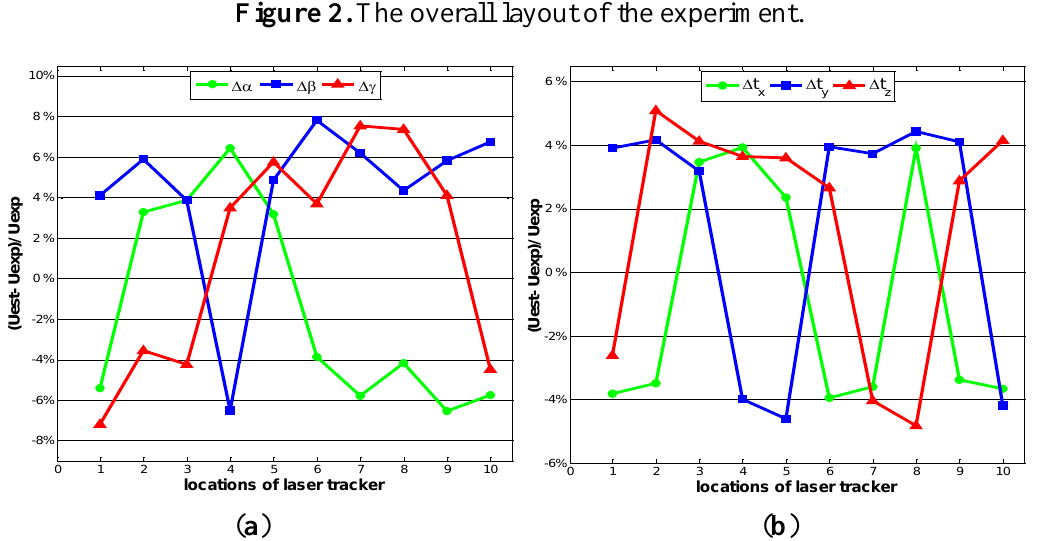
Figure 3. The relative estimation errors of the uncertainties of transformation parameter errors. ( a ) The estimation errors of the uncertainties of rotation parameter errors; ( b ) The estimation errors of the uncertainties of translation parameter